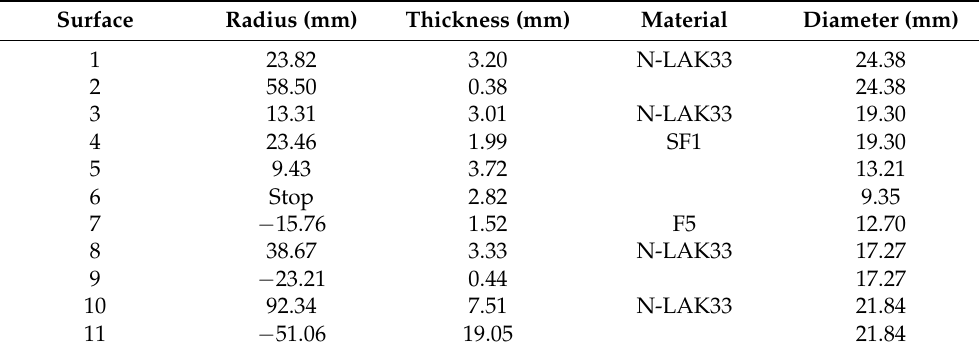
Figure 8. Typical optical layout of a generic Double-Gauss type camera lens. Table 2. Data of the generic Double-Gauss type camera lens we used. Its focal length is 35 mm. Surface